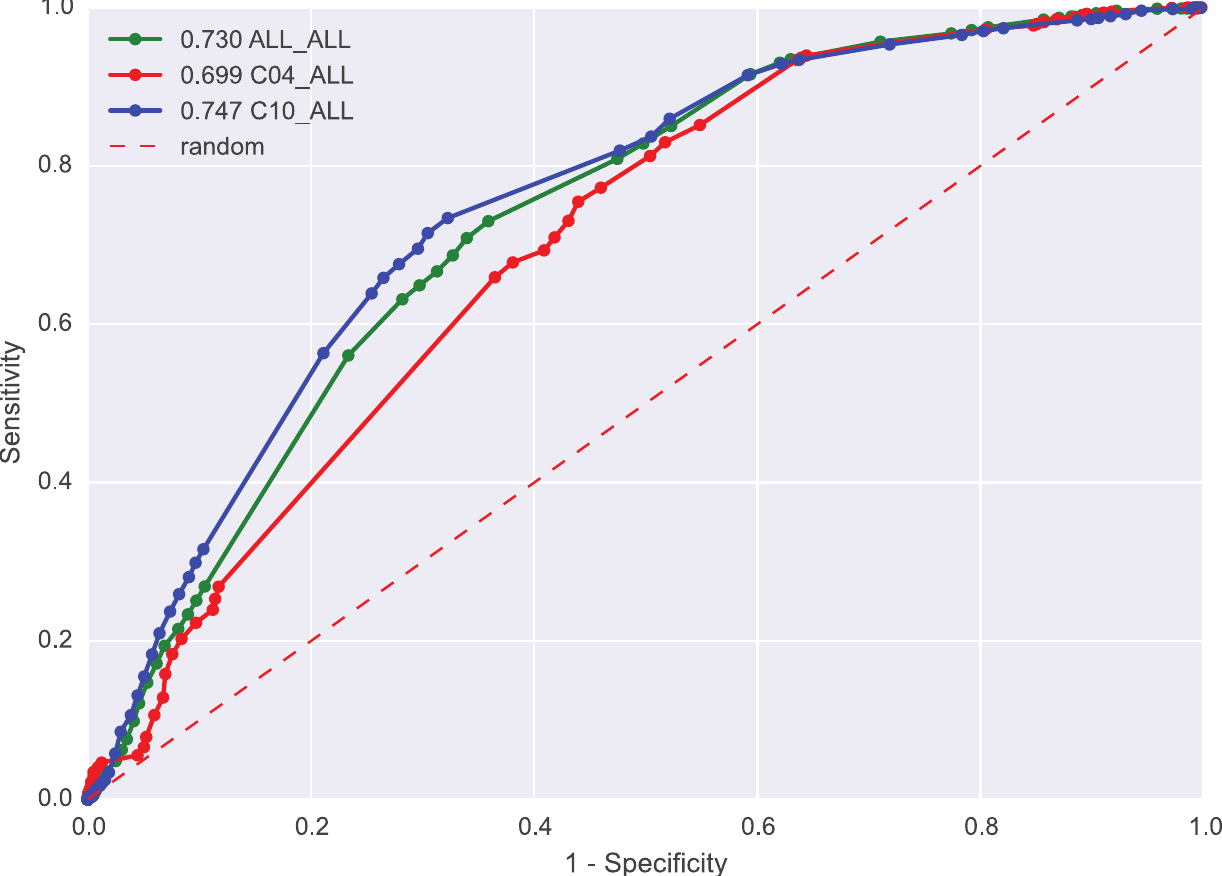
Fig 5. Validating inferred has_indication associations. All 18,889 has_indication associations captured in our integrated network were extracted. These associations were used as a means of validating the ability of our approach to identify known has_indication associations. Note : For each disease category (ALL, C04 and C10) the set of known indications were pruned to only include those containing drugs included in the inferences made by our approach (totalling 17,883). Mapping was done using a Sim value of 0.633, this is equivalent to a distance of two nodes in the MeSH